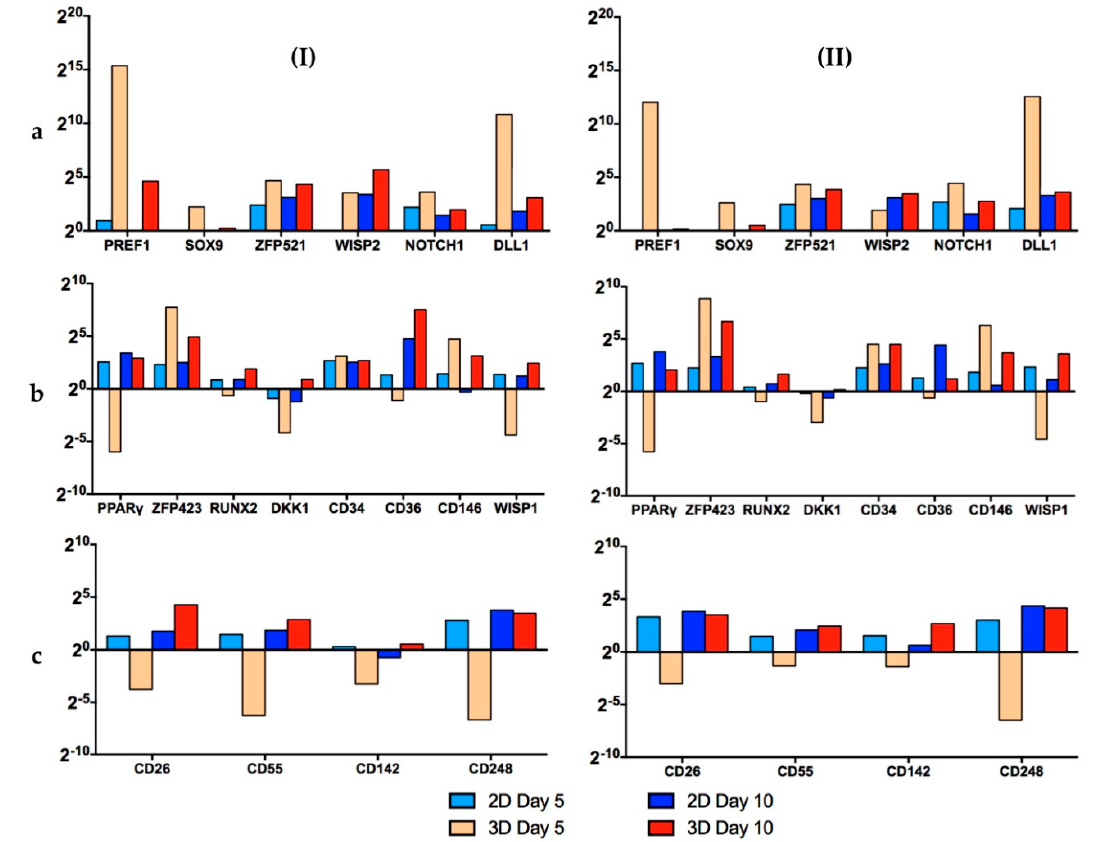
Figure 8. Results of RT-qPCR measurements of donors 080 (I) and 085 (II). The investigated genes were subdivided into 3 groups: ( a ) stemness maintenance genes, ( b ) differentiation regulators/markers and ( c ) lineage hierarchy markers. Data are represented as 2 (- ΔΔ Ct) and related to the beginning of the culture (day 1). A single value for each experimental condition was calculated with this method. This figure is also depicted as “heat maps” and is shown in the “Supplementary Materials” (Figure S3).